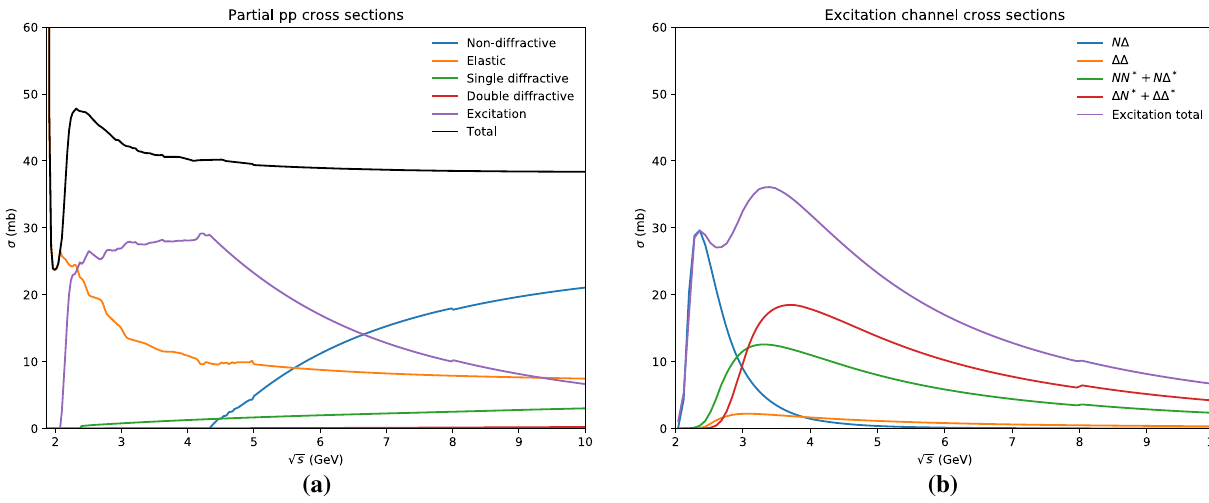
Fig. 6 a All partial cross sections for pp interactions. b Excitation cross sections, according to Eq. (36). Note the small jump at 8 GeV, at the boundary between the tabulated and parameterized